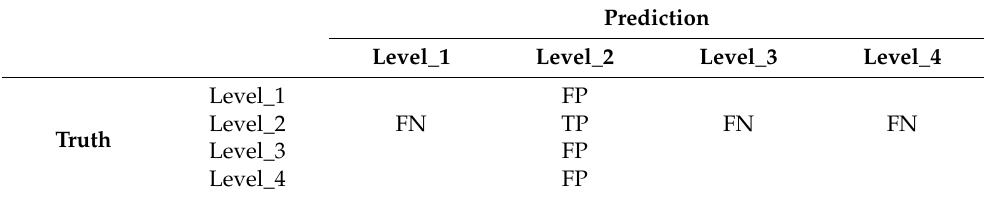
Table 3. An example of the definitions of TP, TN, FP, and FN for damage level_2.